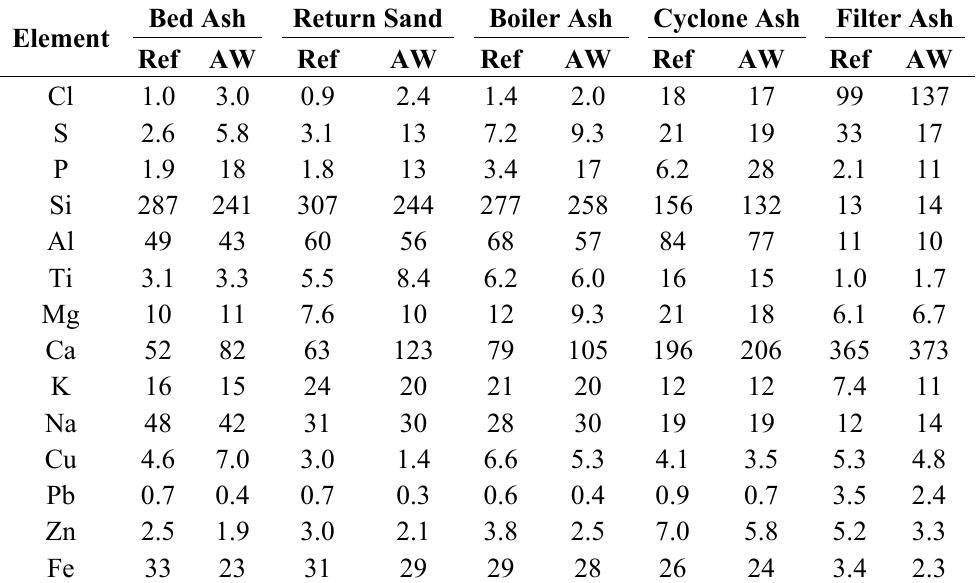
Table 3. Elemental analysis of ashes [g (kg ash) − 1 ].